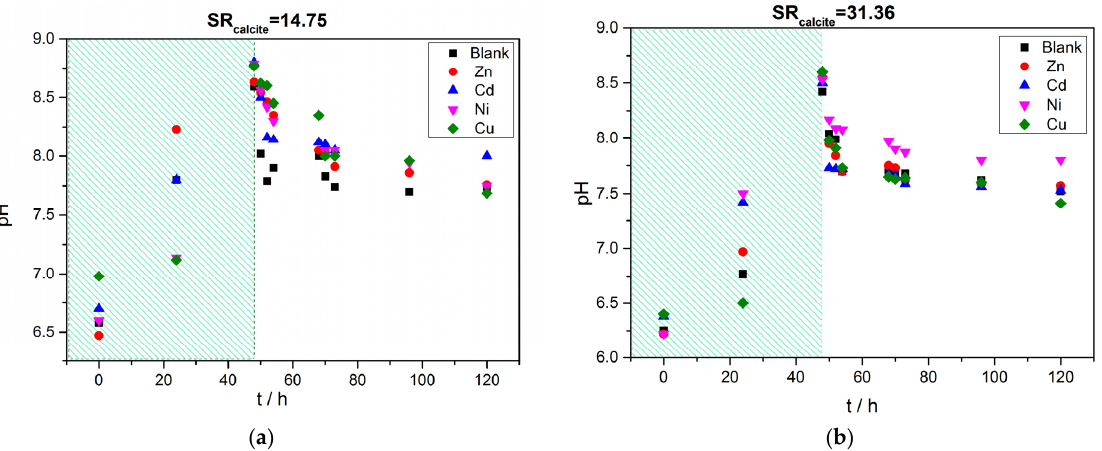
Figure 10. Precipitation of calcium carbonate in supersaturated solutions in the presence of 10 μ M of Zn ( ), Cd( ), Ni ( ), Cu ( ), active A. obliquus culture and the appropriate illumination. Change in pH value as a function of time ( a ) SR calcite = 14.79 and ( b ) SR calcite =31.36, 25 °C, pH 8.50, 0.15 M of NaCl.